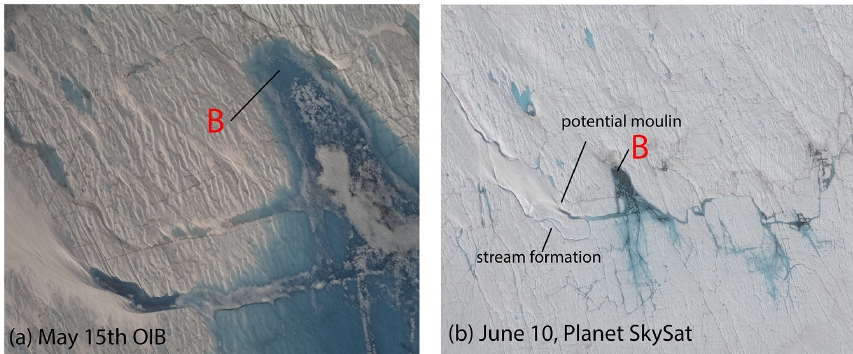
Figure 9. Mechanisms of lake drainage over Lake Julian. (a) CAMBOT imagery from Operation IceBridge flight on 15 May 2019 (30cm resolution). (b) SkySat imagery ( ∼ 1m resolution) on 10 June after large-scale drainage.